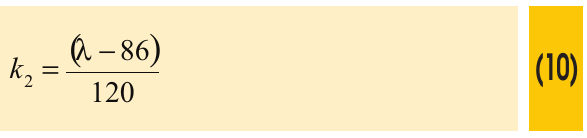
k consider the penalization in the ulti- 2 mate strength of compression due to the instability caused by lo- calized effects of 2nd order. To get magnitude, the graph of Figure